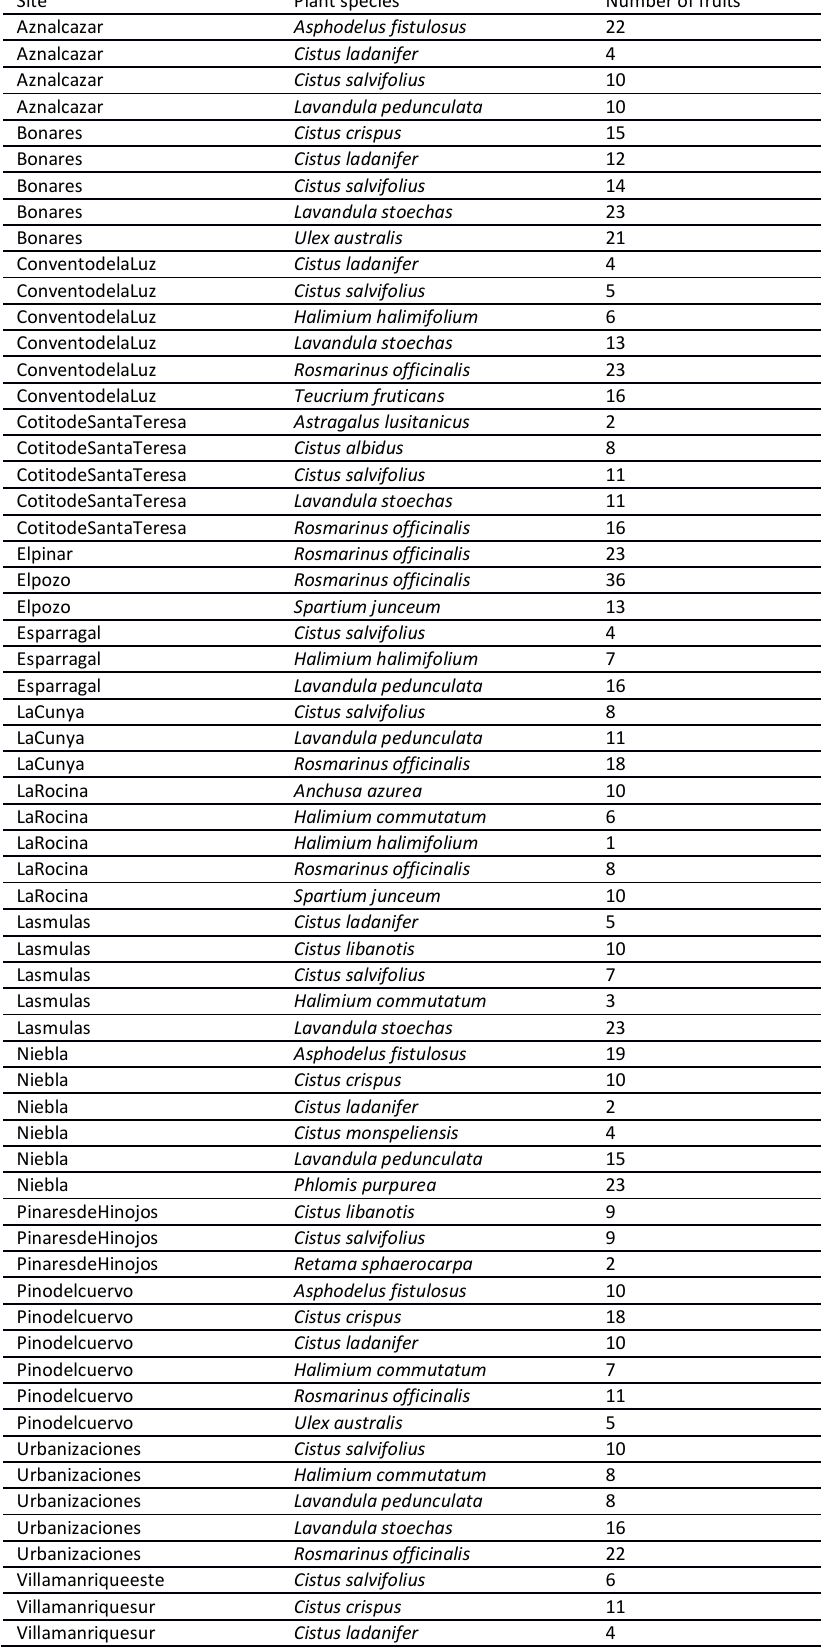
Table S3. Number of fruits per plant species sampled at each